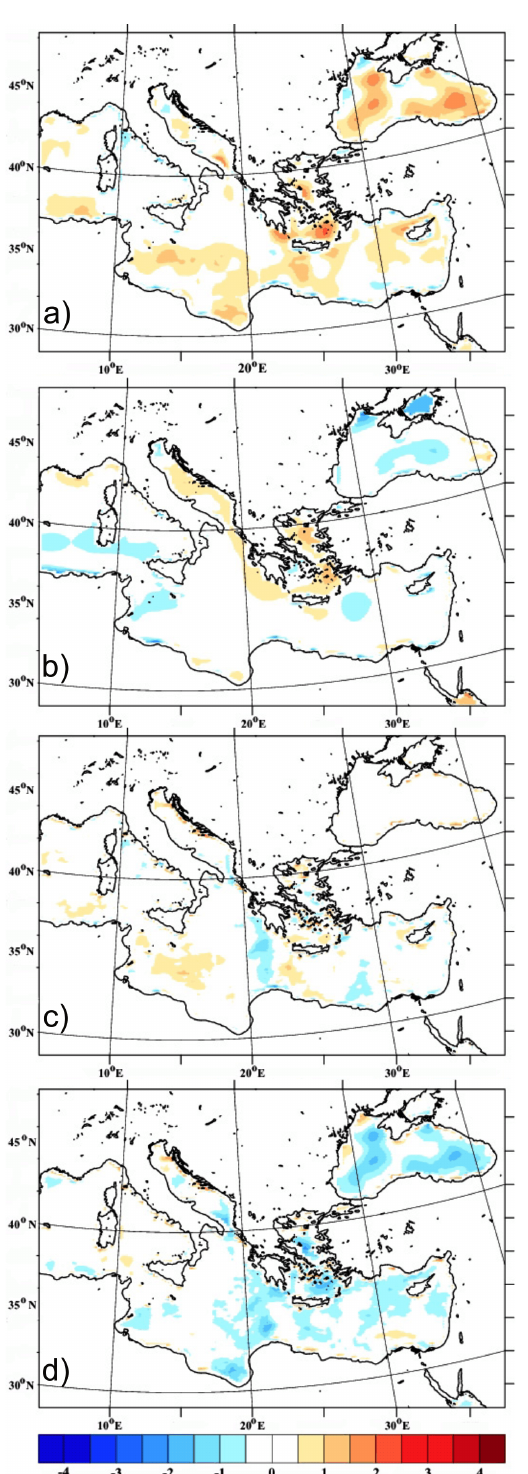
Fig. 4. Maps of the difference (in ◦ K) between the (a) ECMWF and the AVHRR SSTs, (b) ECMWF and the ClimOI SSTs, (c) ECMWF and the GOS SSTs, and (d) AVHRR and the GOS SSTs valid at 00:00 UTC, 21 January 2004. Positive values indicate areas of warmer SSTs in the former dataset.